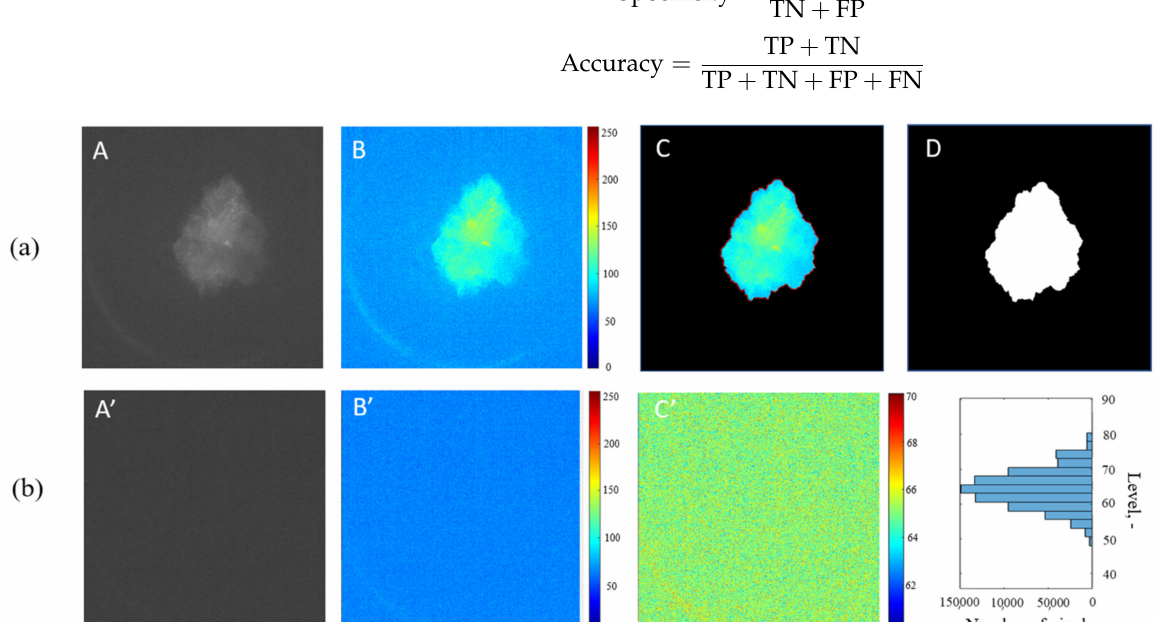
Figure 6. ( a ) Representation of the main steps used to obtain the target image to be compared to the proposed algorithm output. ( b ) Definition of the noise level to be subtracted from ( B ) to obtain the image ( C ). ( A (cid:48) ) represents the image with no flame occurring used as a sample to define the noise level. Figure ( B (cid:48) ) shows, in false colors, image ( A (cid:48) ), while ( C (cid:48) ) is reported to emphasize, from the minimum to the maximum level, the average level of ( A (cid:48) ). The histogram on the right side shows the level distribution of the pixels of ( C (cid:48) ). Image ( D ) shows the result of the binarization